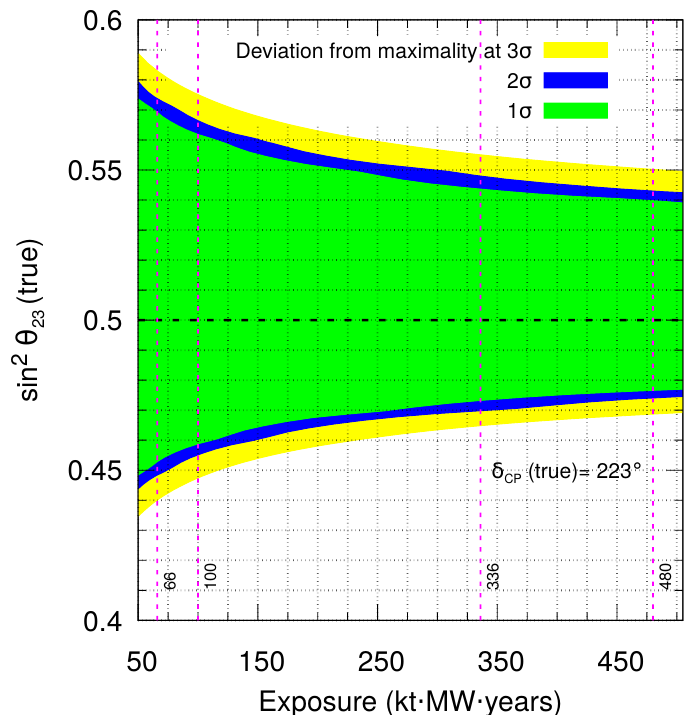
Figure 10 . The discovery of true values of non-maximal sin 2 θ 23 as a function of exposure (kt · MW · years) at 3 σ (yellow curves), 2 σ (blue curves), and 1 σ (green curves) confidence lev- els. For a given exposure, we assume equal run-time in both ν and ¯ ν modes. We consider true NMO and δ (true) = 223 ◦ . We marginalize over δ and ∆ m 2 in the fit in their allowed 3 σ ranges as CP CP 31 given in table